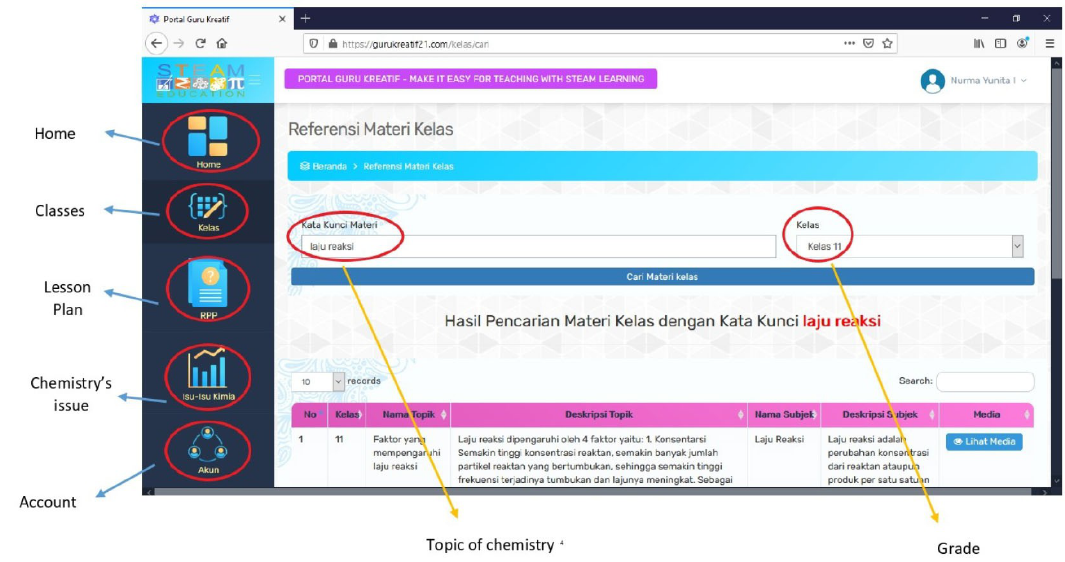
Figure 3. Display of Web-based STEAM online